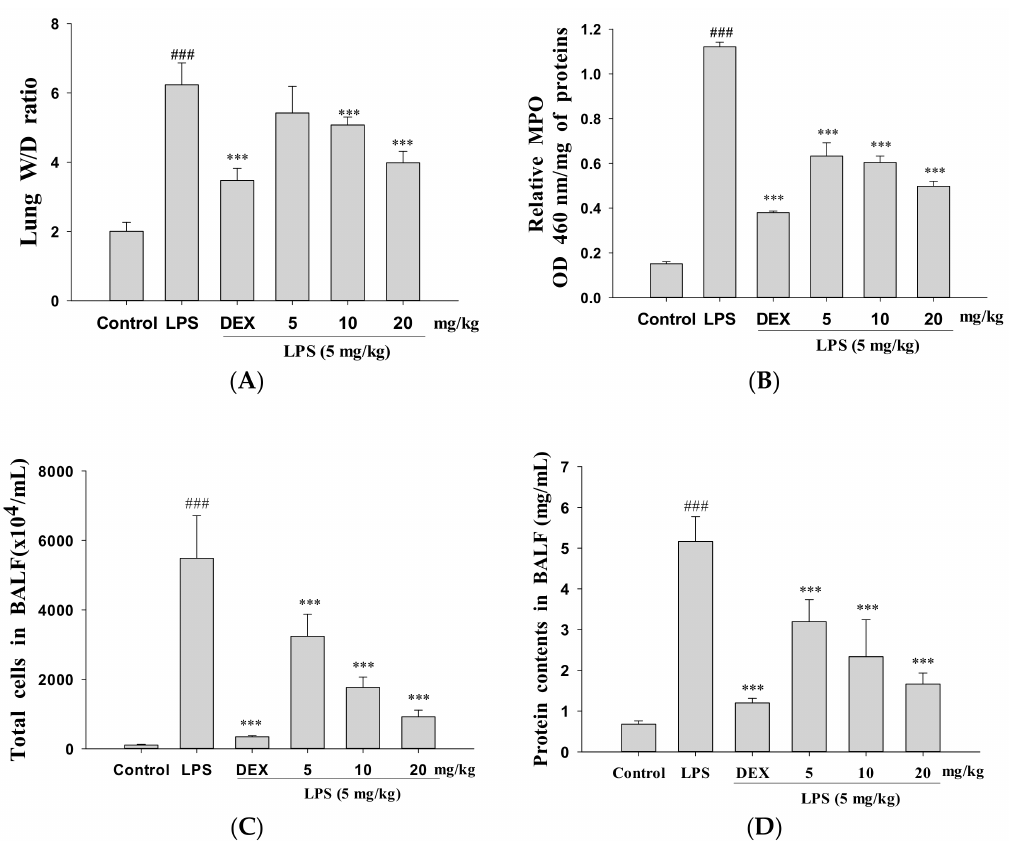
Figure 2. GRh2 improved ( A ) pulmonary edema (wet-dry (W/D) ratio); ( B ) myeloperoxidase (MPO) activity in vivo; and reduced ( C ) cellular counts and ( D ) total protein in bronchoalveolar lavage fluid (BALF). Lung tissues were weighed and calculated the W/D ratio. BALF was harvested to investigate at 6 h after LPS treatment. Total cells and total proteins in BALF were analyzed. Data are presented as mean ± S.E.M. ( n = 5). ### denotes p < 0.001 compared with sample of control group. *** denotes p < 0.001 compared with the LPS-only